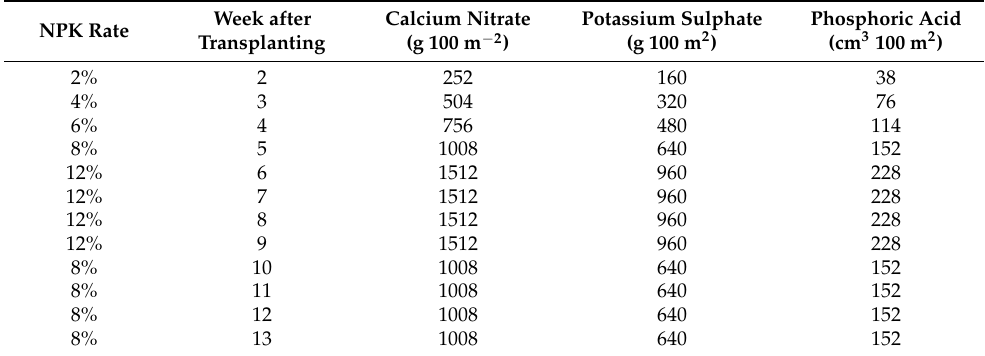
Table 3. Schedule of fertigation system (100% mineral fertilizer as a control